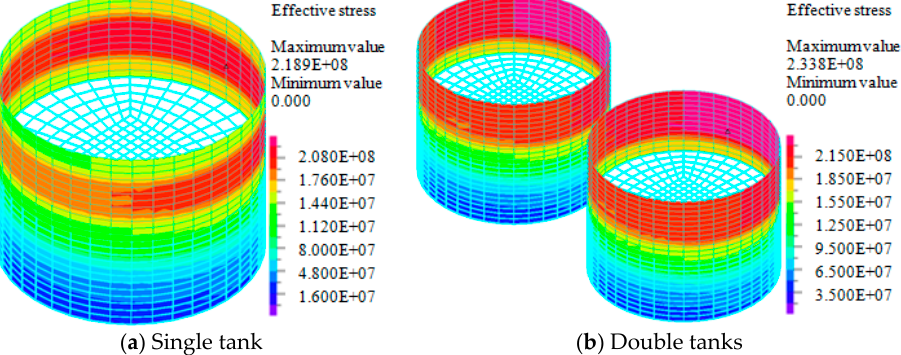
Figure 12. Effect of wind interference on effective stress (unit: Pa).